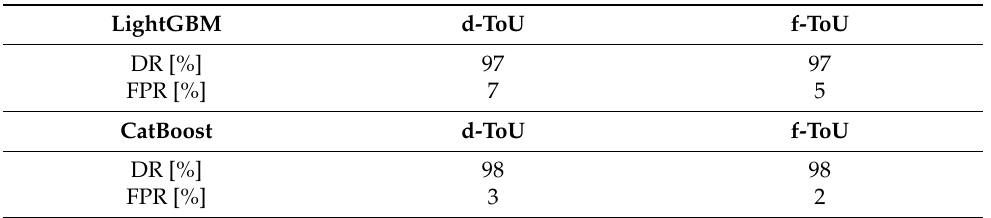
Table 5. Average theft detection performance of LightGBM- and CatBoost-based DETD when using the d-ToU window-based theft cases for an average of 1000 consumers. LightGBM d-ToU